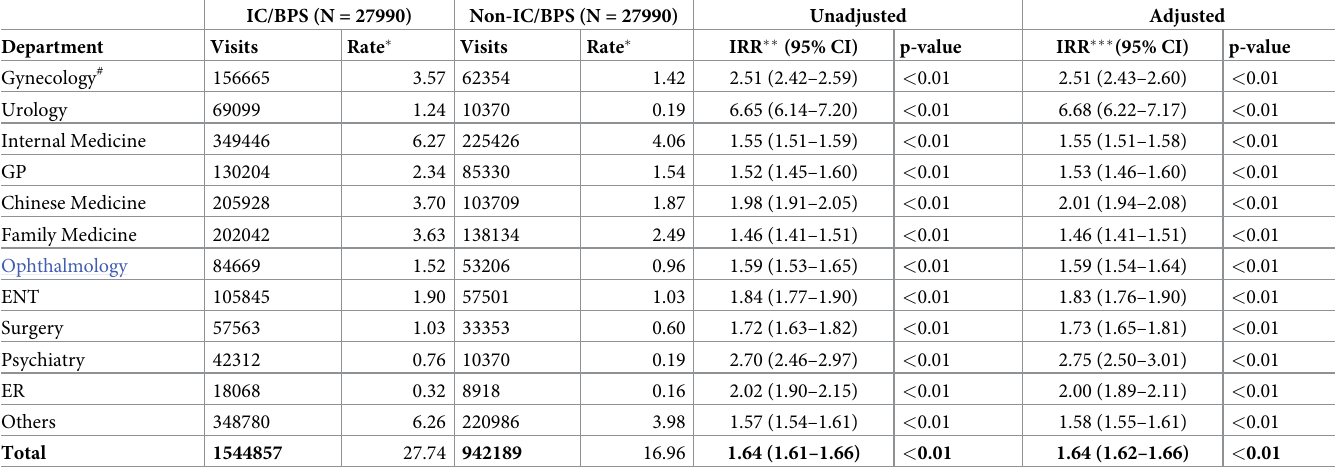
Table 2. Incidence rate ratio (IRR) of outpatient visits between IC/BPS and non-IC/BPS